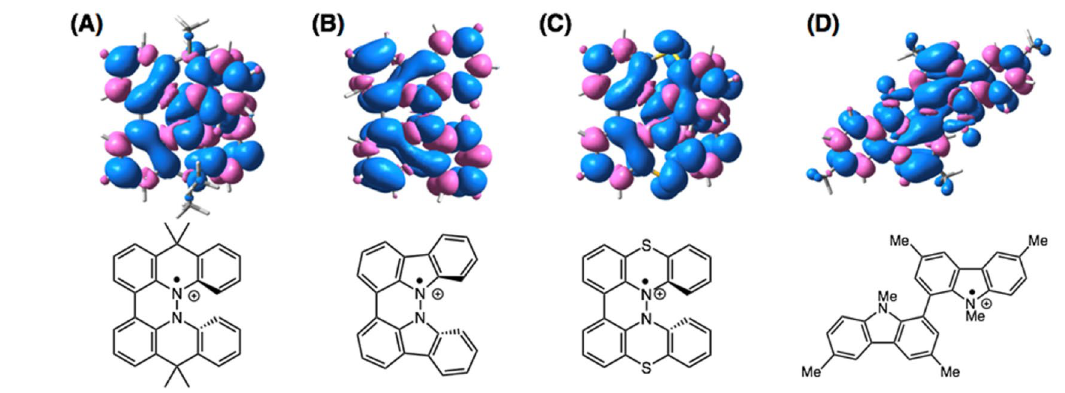
Figure 4. Calculated spin density distributions of monocation radicals of 1b - 3b and 4 [U ω B97XD/6–31 G(d)]. Blue and pink colors indicate positive and negative spin density, respectively. For 4 , t -butyl and ethyl groups were replaced by methyl groups.